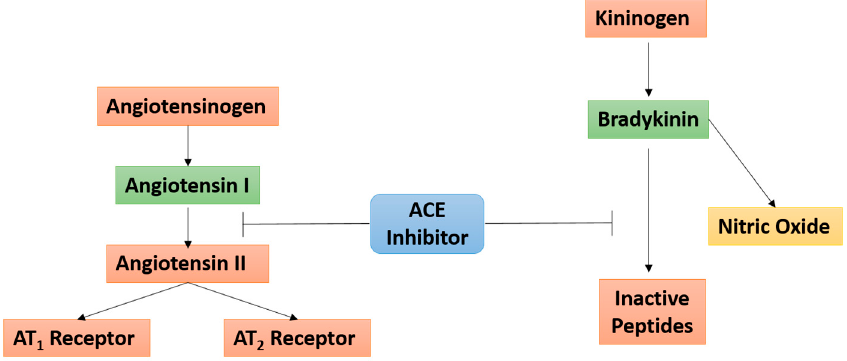
Figure 4. Angiotensin converting enzyme (ACE) inhibitors linking the angiotensin and bradykinin signaling pathways. ACE inhibitors prevent the conversion of angiotensin I to angiotensin II within the renin-angiotensin system, and prevent the conversion of bradykinin to inactive peptides in the kallikrein-kinin system. The T bars are indicative of the inhibitory action of ACE on activated Angiotensin I (as shown by the green box) and Bradykinin. The red boxes indicated inactive proteins.